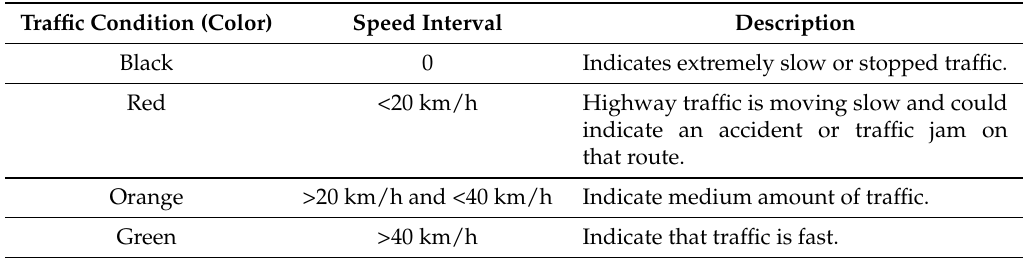
Table 2. Conditions of the